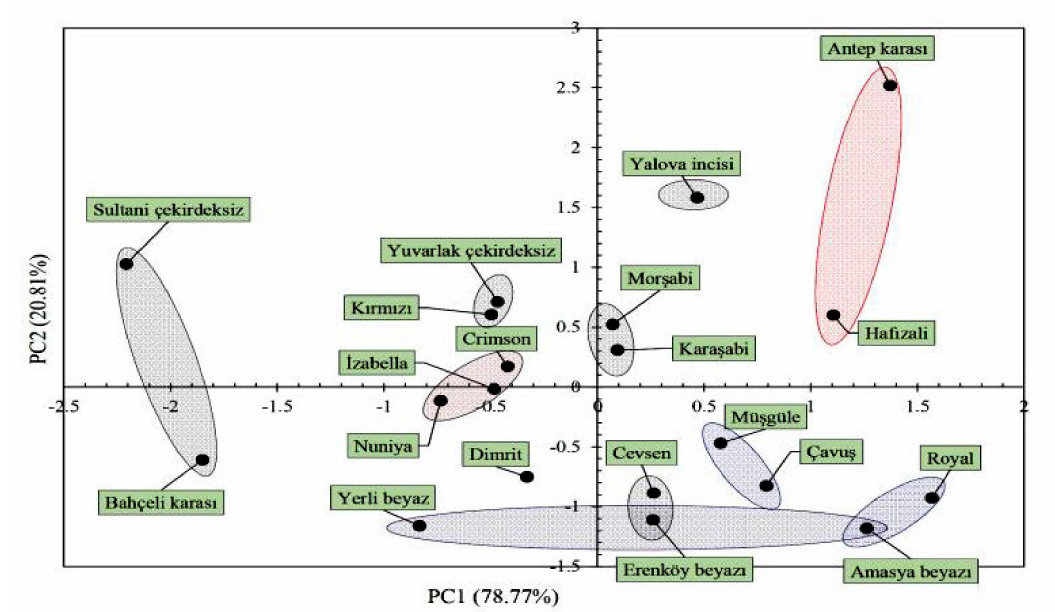
Figure 4. Scatter plot of principal component (PC) loadings defining morphology and dimensional attributes of the grape cultivars.